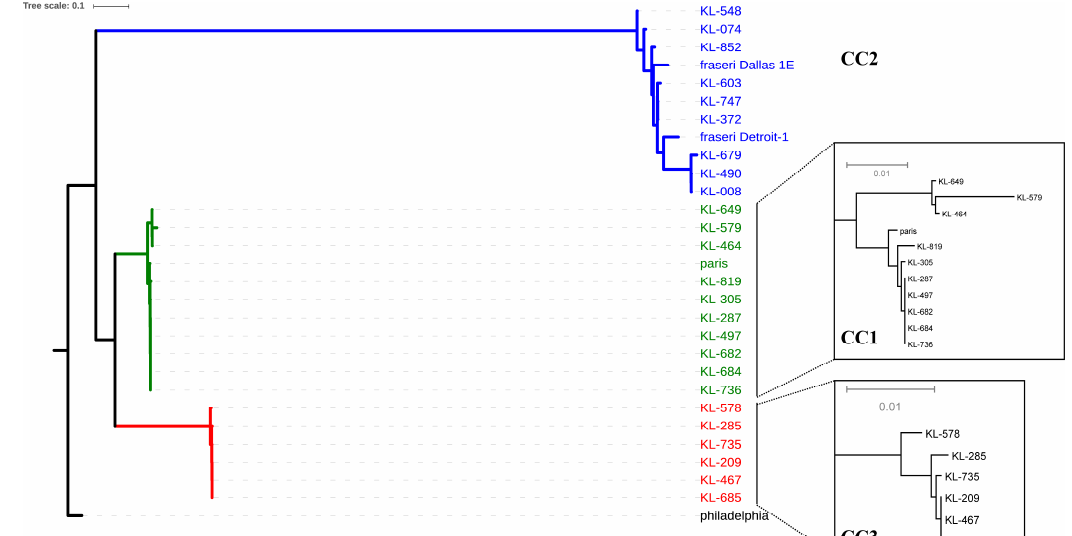
Figure 2. Phylogenetic tree based on a 32586-core-SNP matrixgenome-wide SNPs among the main strains assigned to the three CCs listed in Table 2. A maximum-likelihood tree was constructed using kSNP 3.0 [16]. The lineages including CCs are highlighted by green (CC1), blue (CC2), and red (CC3). Insets show subtrees of CC1 and CC3 isolates. Table 2. Information of the 25 strains assigned to three complexes on genome analysis. No. of DDBJ Accession No. Complexes Years Site in CT a SG ST Strain of Read Data KL287 2006